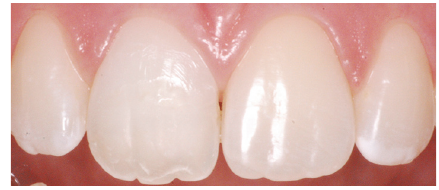
Figure 9: Clinical aspects after composite resin restoration.